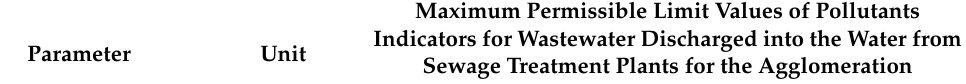
Table 3. Acceptable values of pollution of waters entering the receiver. PE, population